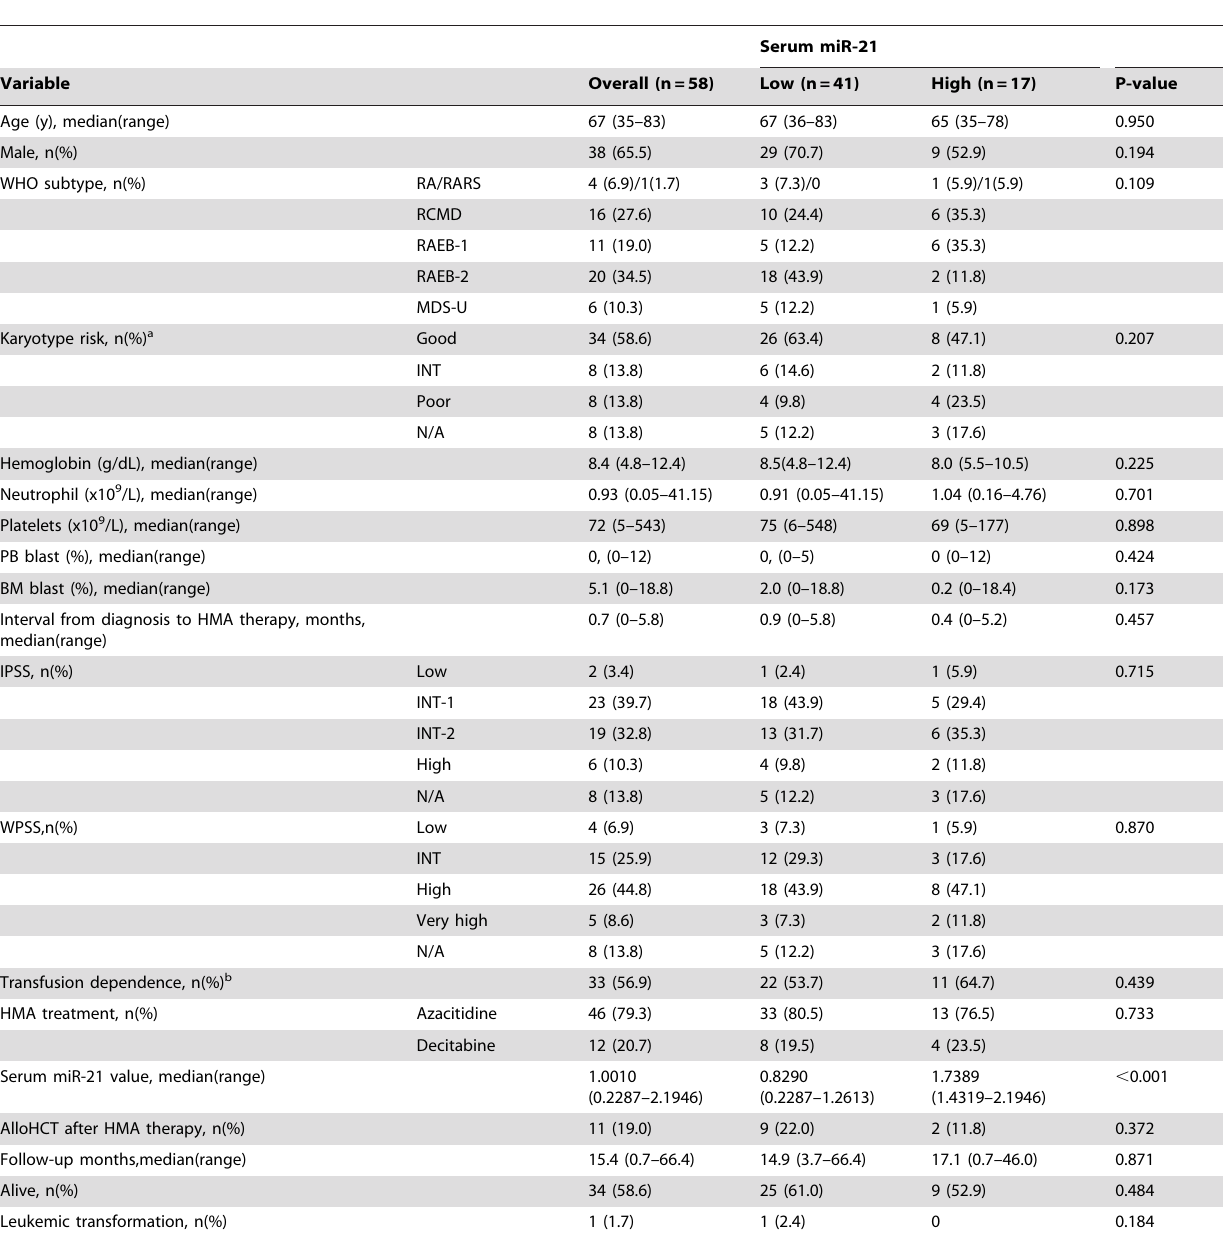
Table 1. Overall characteristics of patients and stratification according to serum miR-21